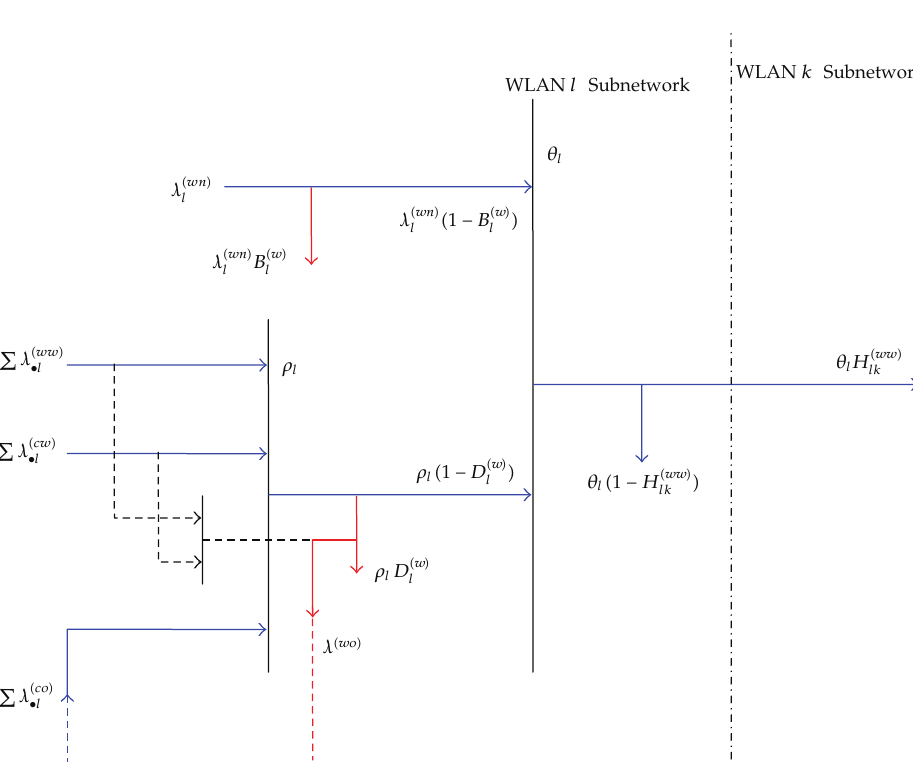
Figure 5: Horizontal handover tra ffi c between